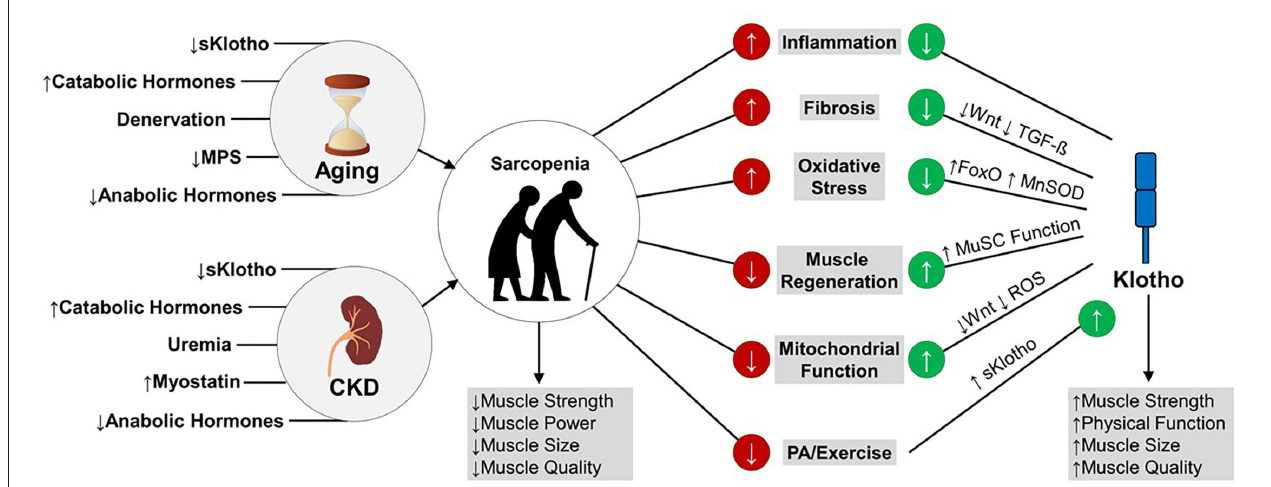
FIGURE 1 | Mechanisms of Klotho’s effects on muscle function in aging and CKD. Age- and CKD-related declines in skeletal muscle strength, power, size, and quality lead to sarcopenia. These declines in muscle structure and function are partly driven by increased inflammation and oxidative stress, impaired muscle regeneration in favor of fibrosis, and impaired mitochondrial function. Emerging data suggest that enhancing Klotho levels may reverse sarcopenia by downregulating pro-fibrotic pathways, enhancing muscle satellite cell and mitochondrial function, and downregulating oxidative stress and inflammation. Accordingly, higher circulating levels of Klotho are associated with greater muscle strength and physical function, higher lean mass, and higher muscle quality. Klotho levels have been shown to increase in response to exercise. MPS, muscle protein synthesis; TGF-ß, Transforming Growth Factor-ß; FoxO, Forkhead box protein O; MnSOD, Manganese Superoxide Dismutase; MuSC, Muscle Satellite Cell; ROS, Reactive Oxygen Species; sKlotho, soluble Klotho; PA, Physical